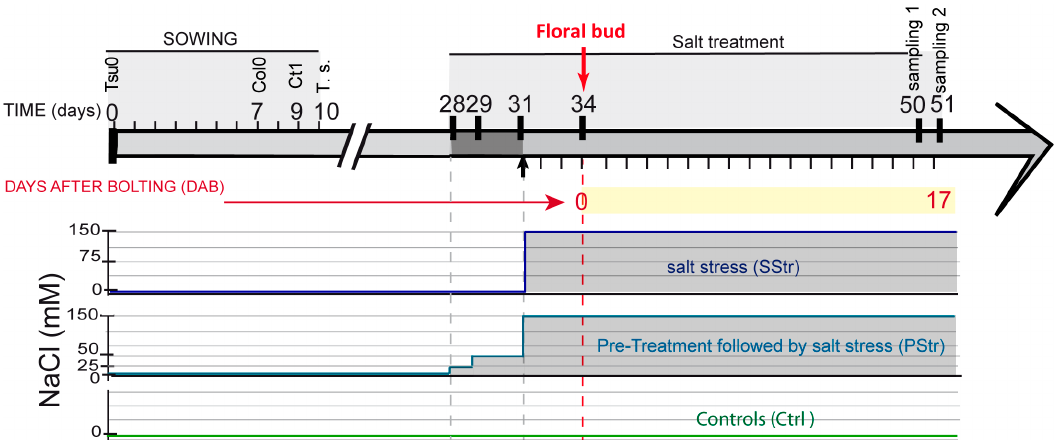
Figure 1. Design of the experimentation. Staggered sowing of the genotypes, with Tsushima-0 (Tsu0) sown at day 0, then Columbia-0 (Col0), Catania-1 (Ct1), and Thellungiella salsuginea (T.s.) sown 7, 9, and 10 days later, respectively, so as to synchronize bolting. Application of the salt treatment started three days before the floral bud appearance. The pretreatment phase (i.e., acclimation) of 150 mM of salt treatment preceded the beginning by three days. Sampling of the rosette and floral stem for the measurement of the fresh weight and dry weight was done at 16 days after bolting (DAB). Sampling of the main floral stem for anatomic studies and sugar quantifications was done at 17 DAB. Measurements of the stem height were done from 7 DAB to 16 DAB.